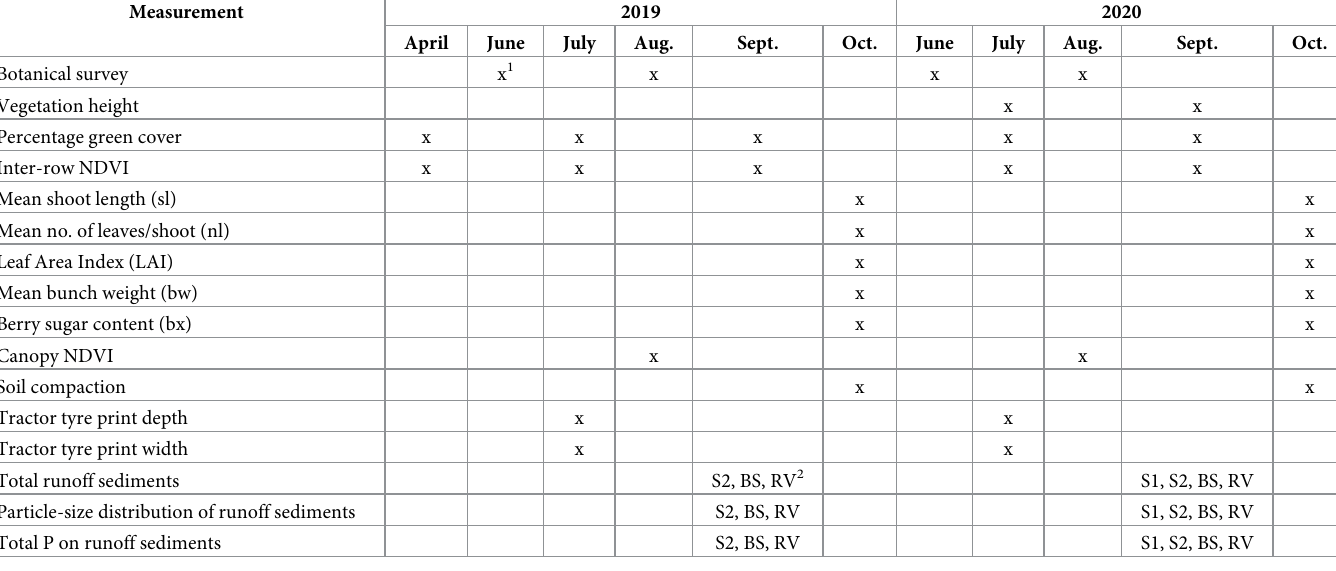
Table 3. List of measurements and month and year they were